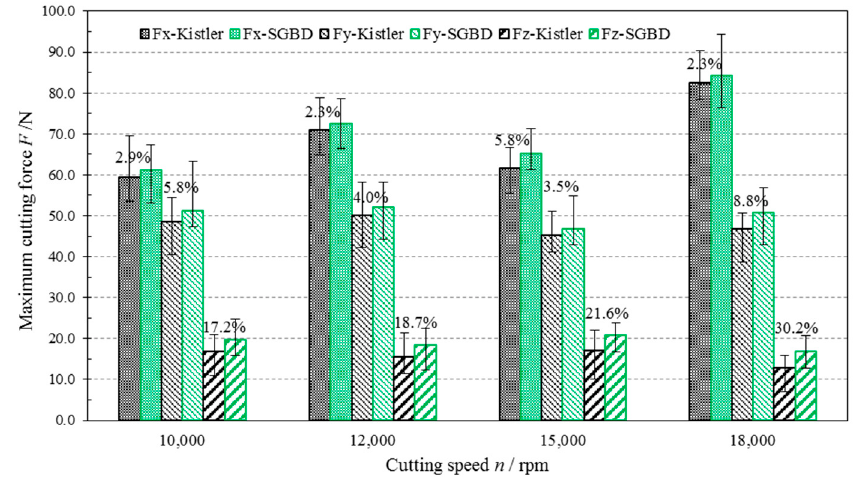
Figure 10. The maximum cutting forces were obtained by SGBD and Kistler (10,000~18,000 r/min).